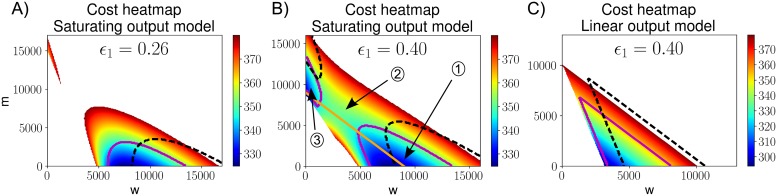
Intermediate heteroplasmies can be less efficient than either wildtype or mutant homoplasmy.A visualization of the cost function in (w, m) space is shown for both saturating and linear output models, for various mutant pathologies (described by ϵ1). For visualization purposes, states in which cellular demand cannot be satisified are shown in white. Cells in these states may still survive by e.g. increasing glycolysis (effectively reducing mitochondrial demand). This figure assumes high copy numbers, results are qualitatively similar for low copy numbers. The actual cost values (given by the colour map) are of lesser importance for our findings, we rather focus on the qualitative shape of the cost function. A: The magenta (solid) and black (dashed) lines show the contour of the demand-satisfying region when demand is increased by 10%, or demand is increased by 50% and cellular resource availability is increased by 35%, respectively. B: The orange line corresponds to constant total copy number; moving up along this line increases heteroplasmy. Cells in region 1 or region 3 are more efficient, and show a lower cost, than cells in region 2. C: The linear mitochondrial output model does not show a decreased efficiency at intermediate heteroplasmy values.